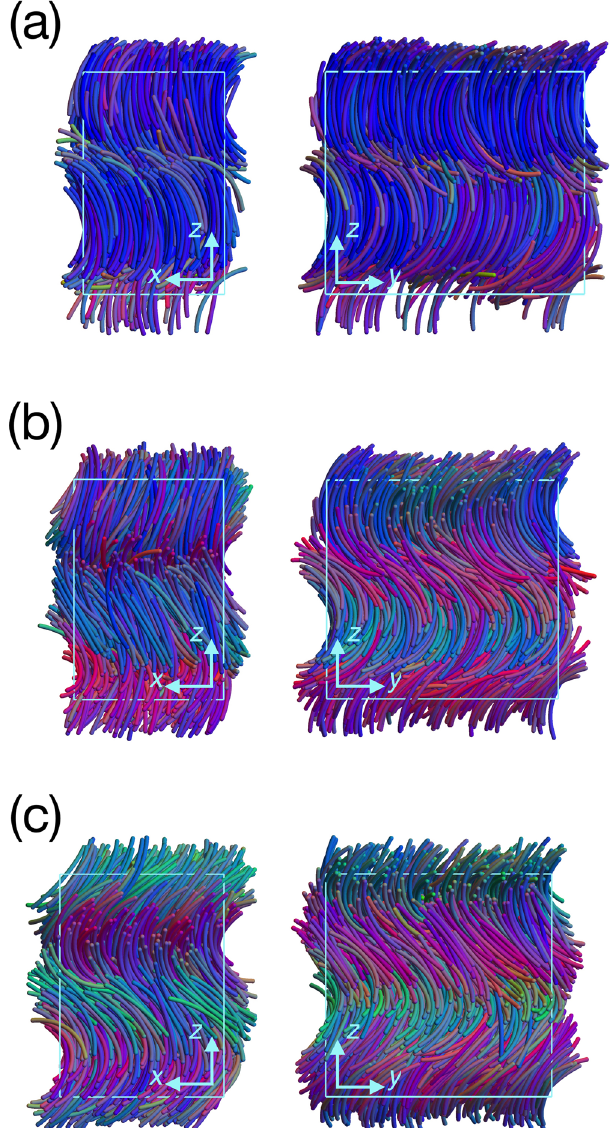
Fig. 4 Splay-bend smectic Sm SB , twist-splay-bend smectic Sm TSB , and twist-bend nematic N TB phases. Typical con fi gurations of ( a ) an Sm SB phase with conical angles θ a ~ 0.76 and θ b ~ 0 at packing fraction η = 0.394 (box size 55.5 D × 30.3 D × 47.7 D ), b an Sm TSB phase with conical angles θ a ~ 0.87 and θ b ~ 0.51 at packing fraction η = 0.371 (box size 52.0 D × 33.4 D × 49.1 D ), and ( c ) an N TB phase with conical angles θ a ~ θ b ~ 0.83 at packing fraction η = 0.354 (box size 49.9 D . 3 D × 49.3 D ) along an expansion of a system of hard curved spherocylinders of length L / D = 19 and opening angle Ψ =